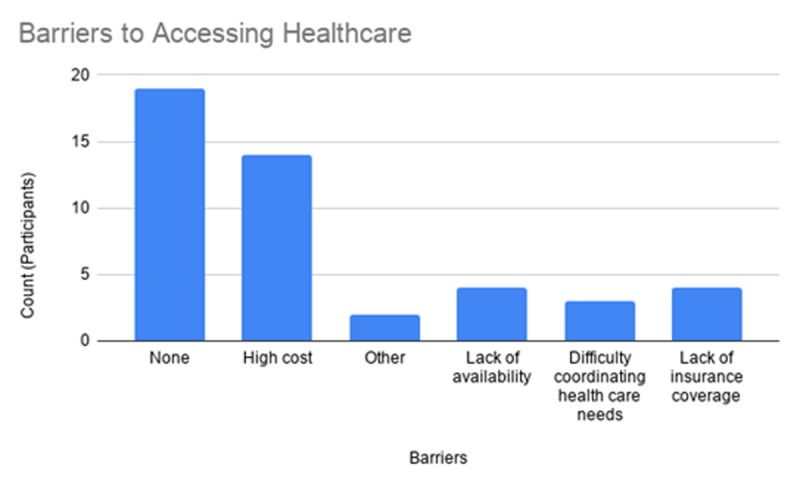
Barriers to Accessing Health Care.